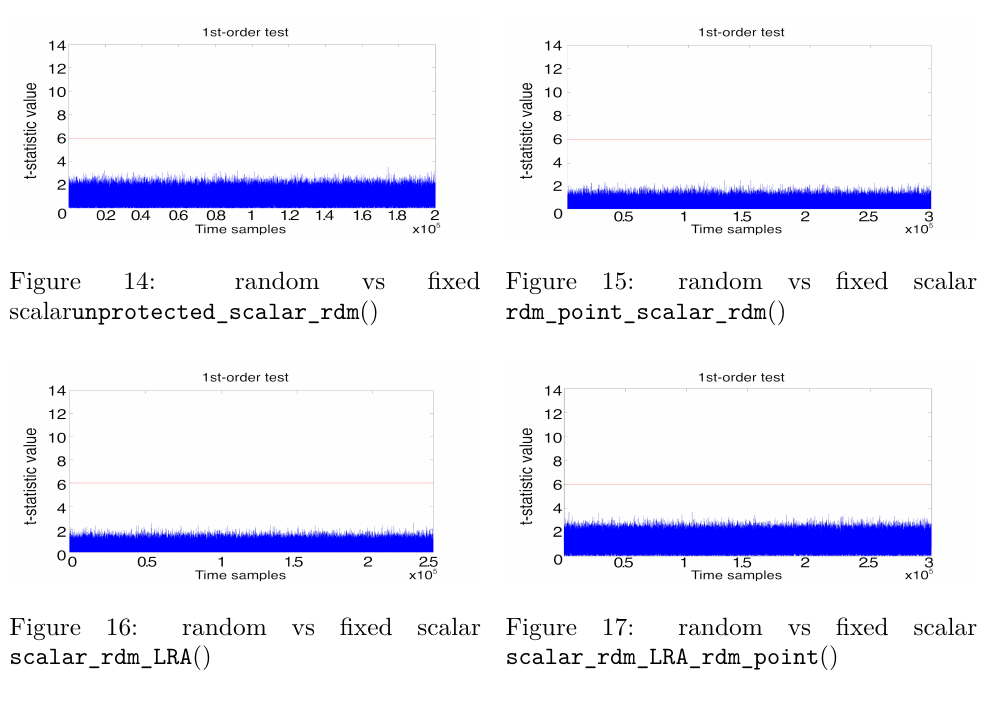
Figure 16: random vs fixed scalar scalar_rdm_LRA ()